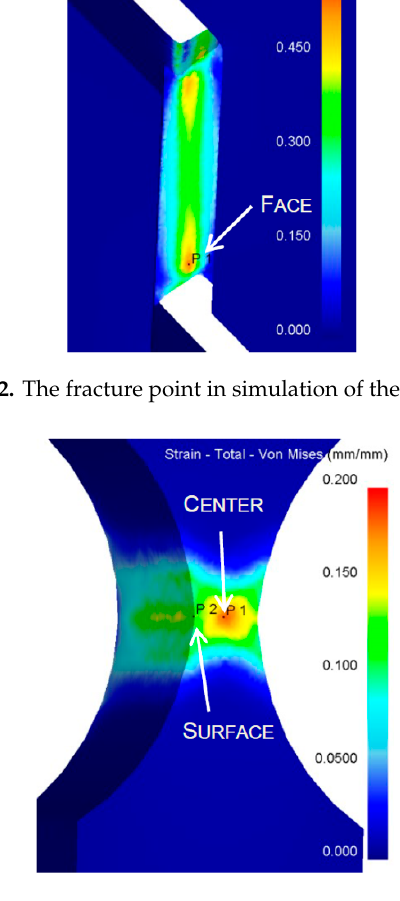
Figure 23. The fracture point in simulation of the plane strain test (longitudinal section).